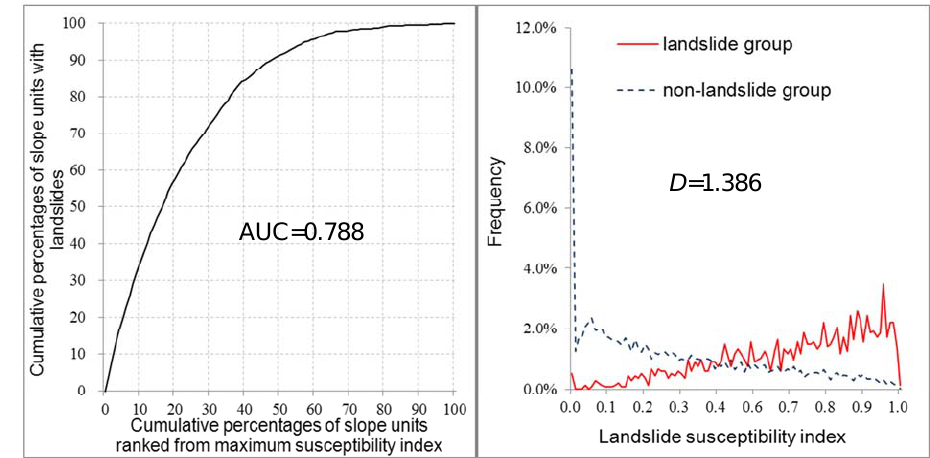
Fig. 6. Success rate curve and frequency distribution of landslide and non-landslide groups for the established model.